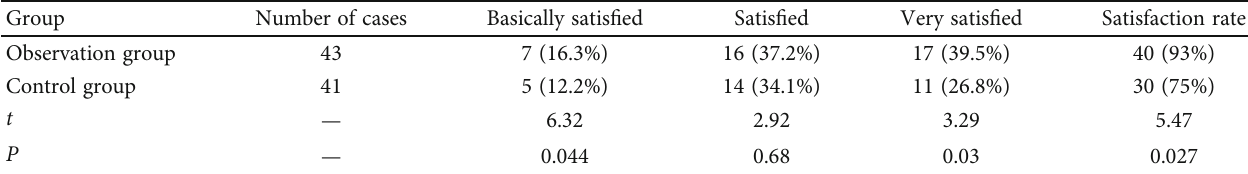
Table 3: Comparison of nursing satisfaction between the two groups.